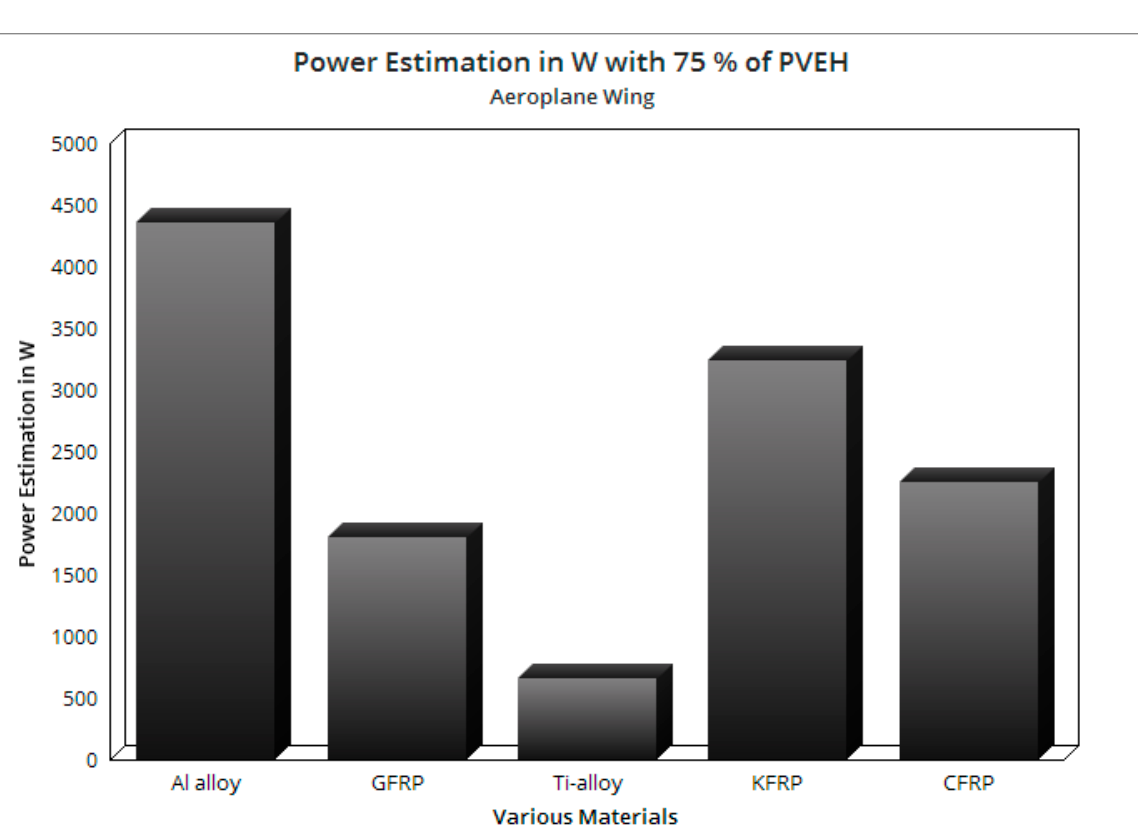
Figure 30. Power (P 0 ) in W with 100% attachment coverage—airplane wing.